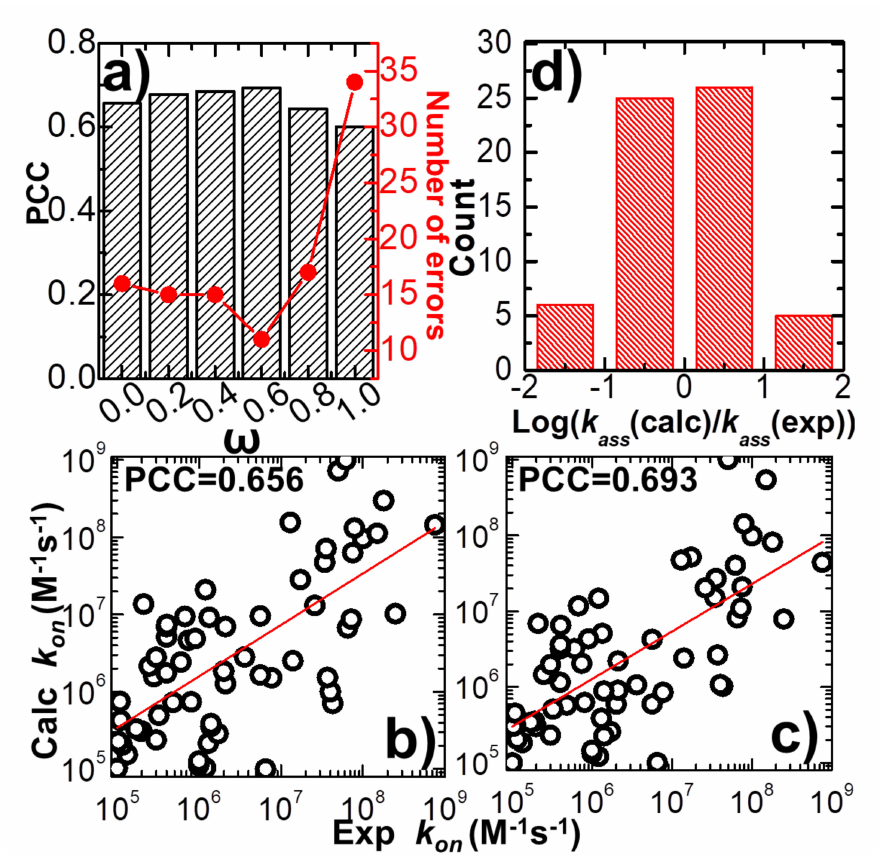
Figure 2. We adjusted the value of parameter ω , which balances the weights between the physics-based and statistics-based potentials from 0 to 1. Under each specific value, the association rates were calculated for all protein complexes in the benchmark and compared with their corresponding experimental measurements. The calculated Pearson correlation coe ffi cient (black bars) and the number of errors (red dots and line) in the correlation between simulated and experimental association rates are plotted in ( a ) as a function of the value of this weight constant. One-to-one detailed comparisons between simulated and experimental association rates are shown in the log 10 base plots when the value of the weight constant equals 0.0 ( b ) and 0.6 ( c ), respectively. The red lines are from the linear regression fit between simulated and observed log 10 k on values. The slope of the red line in ( b ) equals 0.66 (standard error equals 0.093) and the intercept equals 2.21 (standard error equals 0.61), while the slope of the red line in ( c ) equals 0.63 (standard error equals 0.084) and the intercept equals 2.35 (standard error equals 0.55). We further calculated the common logarithm of the ratio between simulated and experimental association rates. The distribution of our calculations for all 62 protein complexes is plotted on histograms in ( d